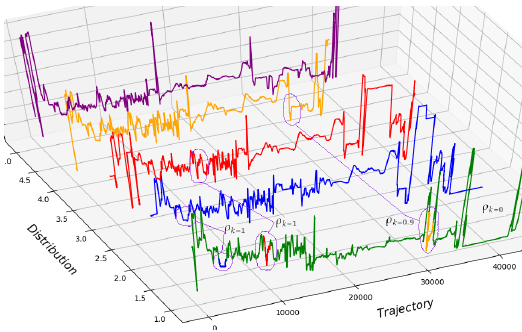
Figure 4. Specific ρ segments in the data-set Φ